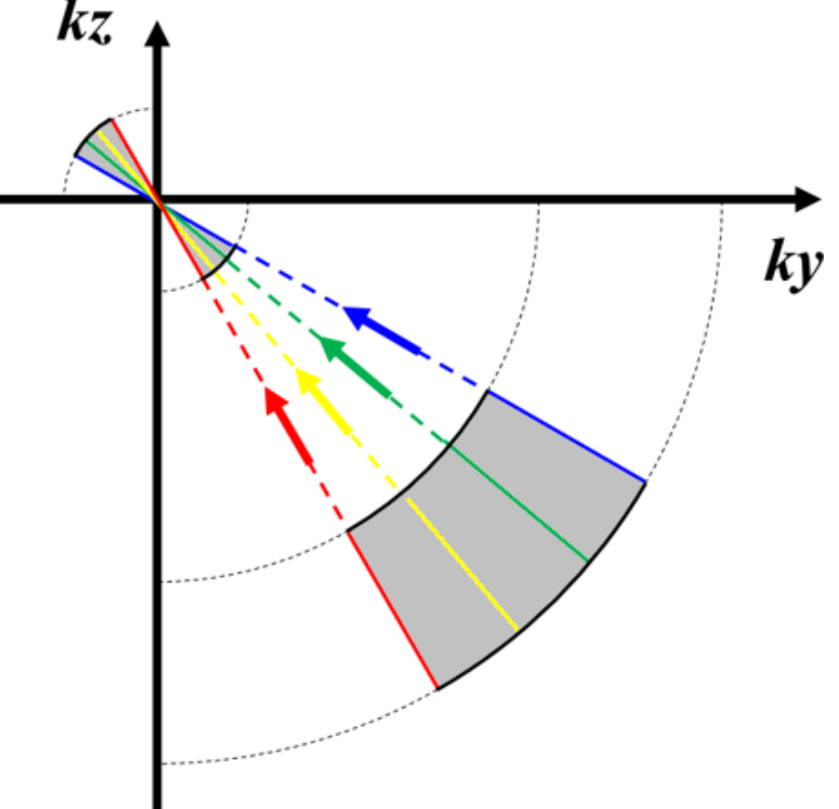
Figure 6. Demodulation of the reflectivity map depicted in the { ky , kz } domain. The multiplication by the F demod ( y , z ) function defined in Equation (13) takes every spectral line into baseband along the direction defined by the local line-of-sight.